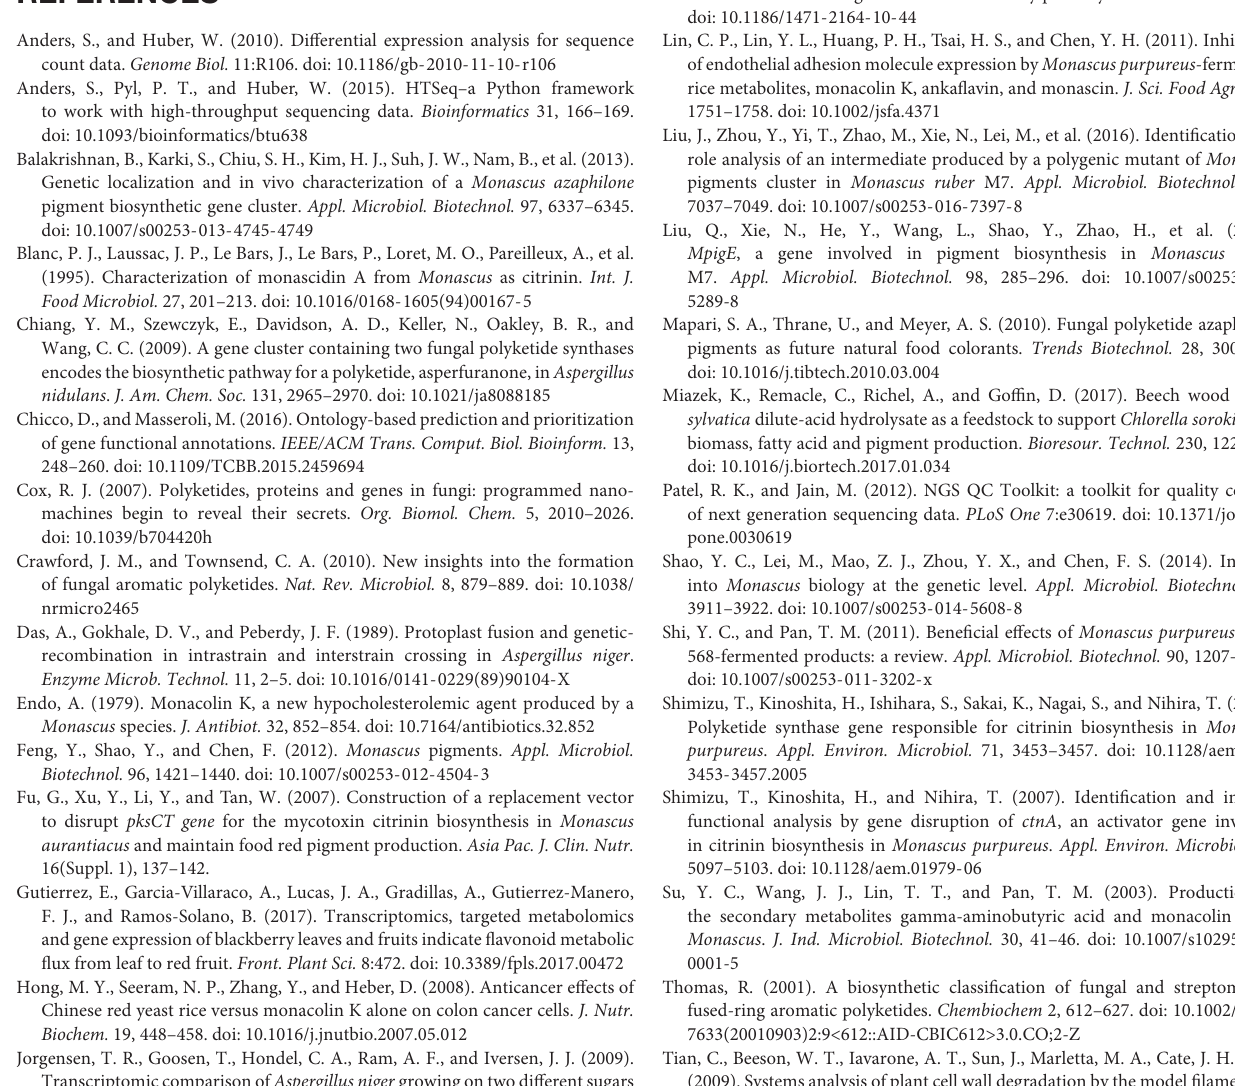
TABLE S1 | The profiles of RNA-seq reads mapped to the genome of Monascus purpureus and the differential expression analysis.